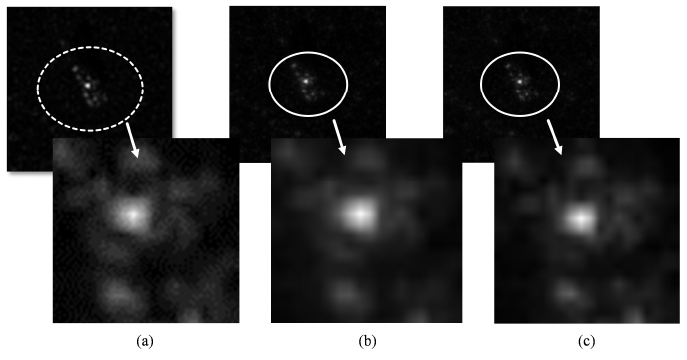
Figure 9. Reconstruction comparison between baseline and transfer learning. ( a ) input image; ( b ) reconstruction image of SCAE training from scratch; ( c ) reconstruction image of transfer